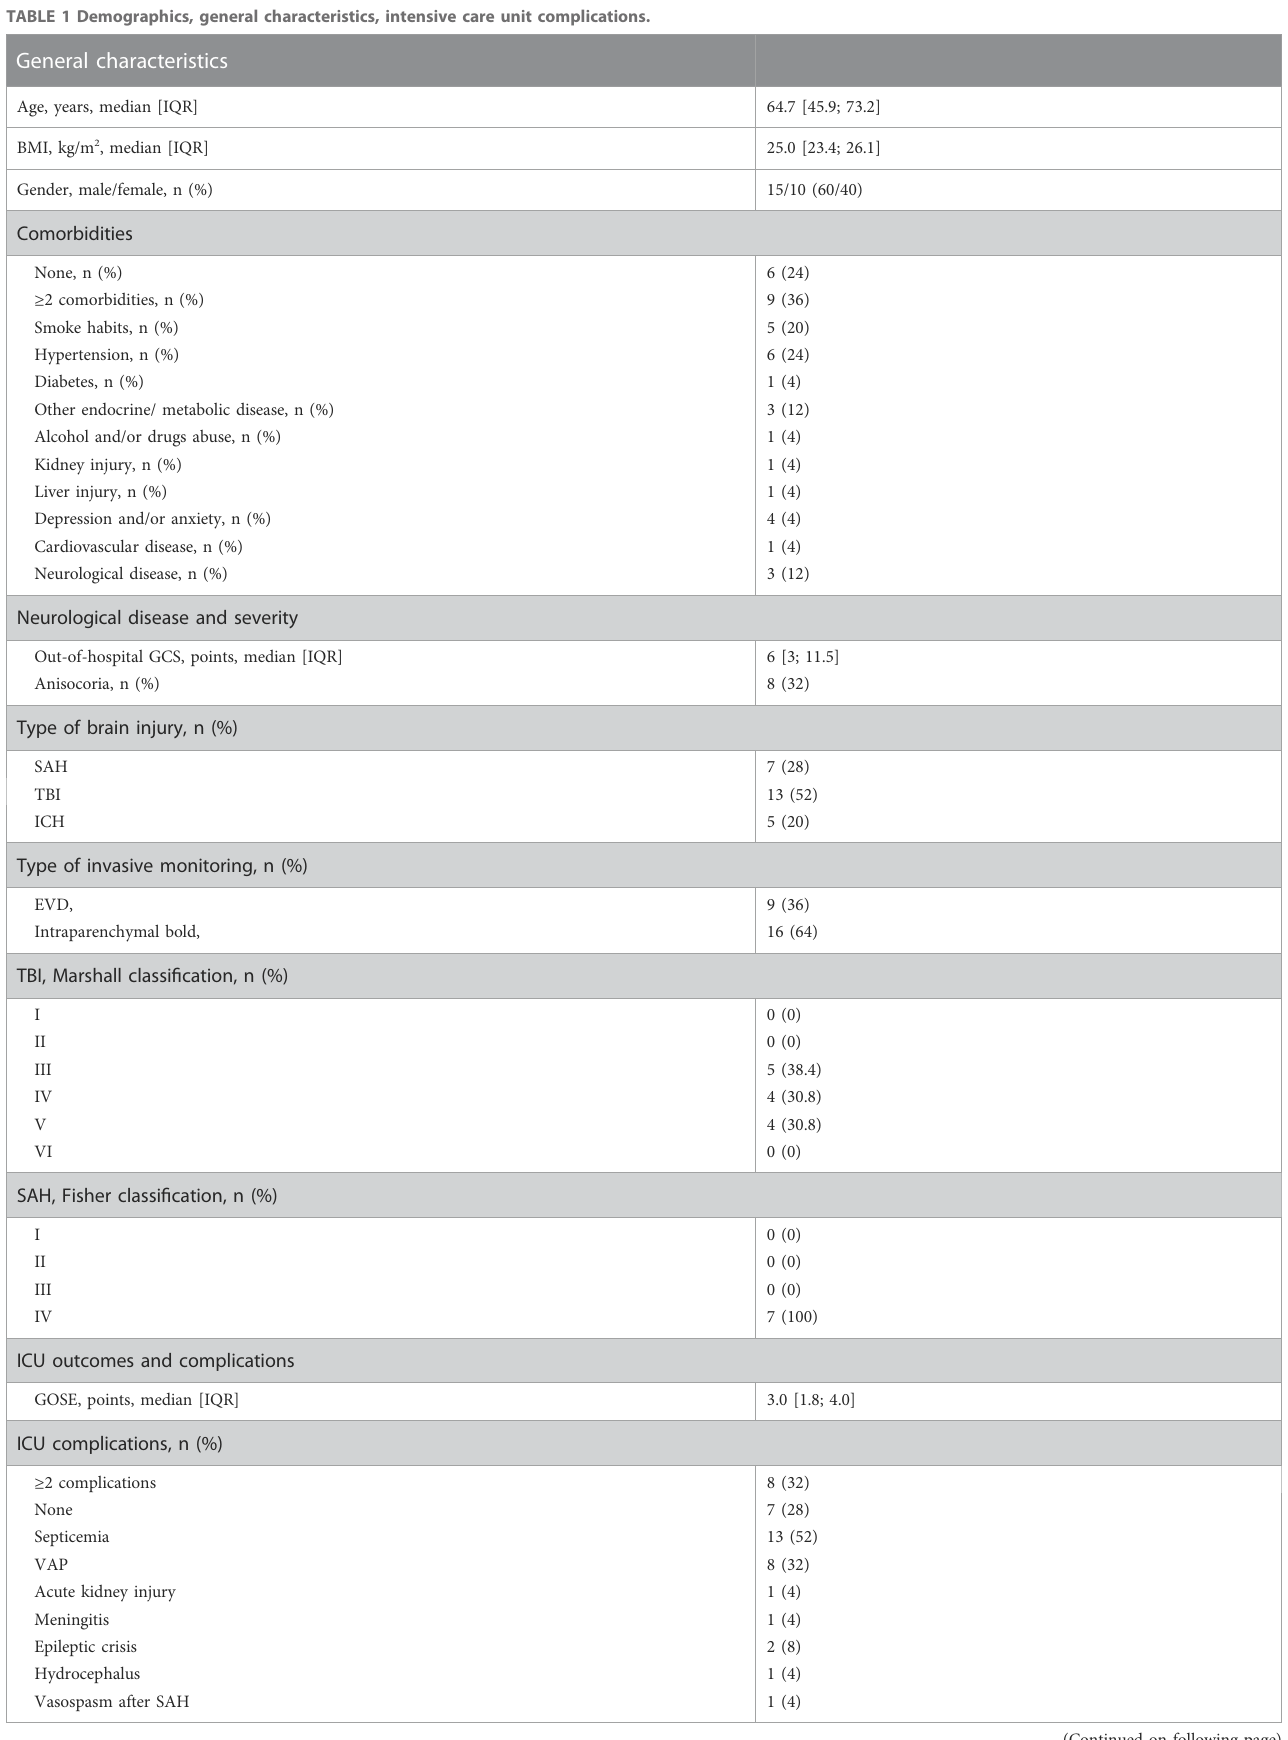
TABLE 1 Demographics, general characteristics, intensive care unit